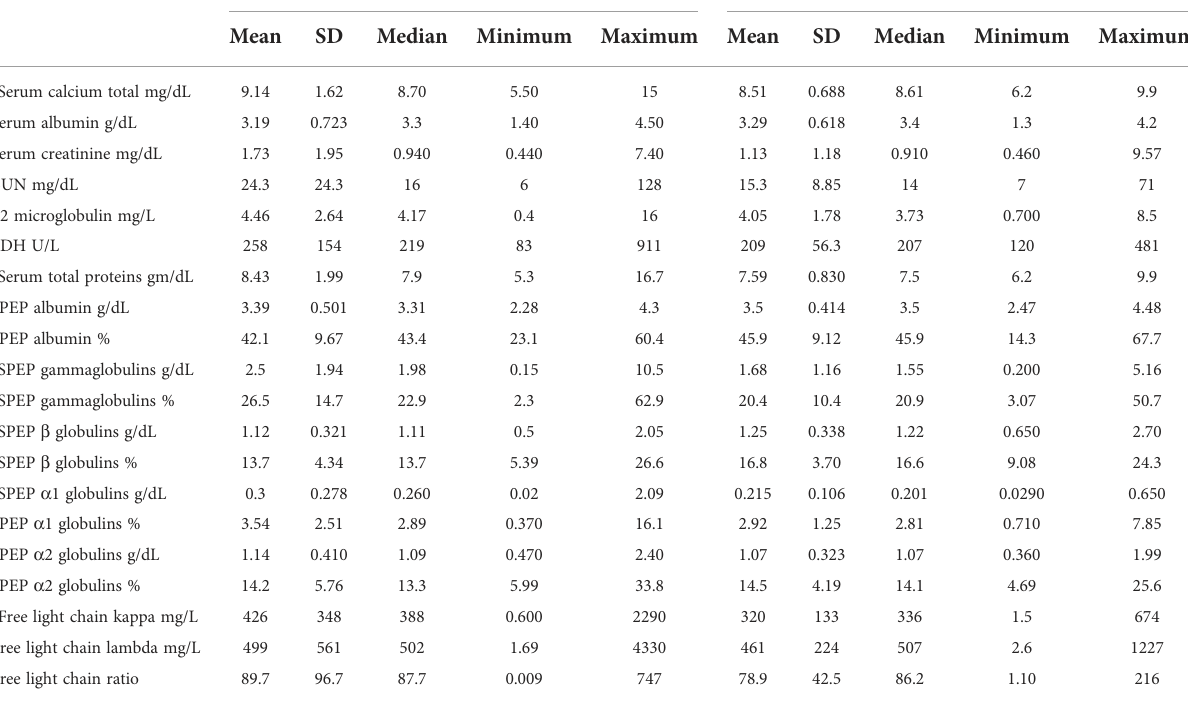
TABLE 5 Laboratory pro fi les of the MM patients at before and after treatment. Before treatment After